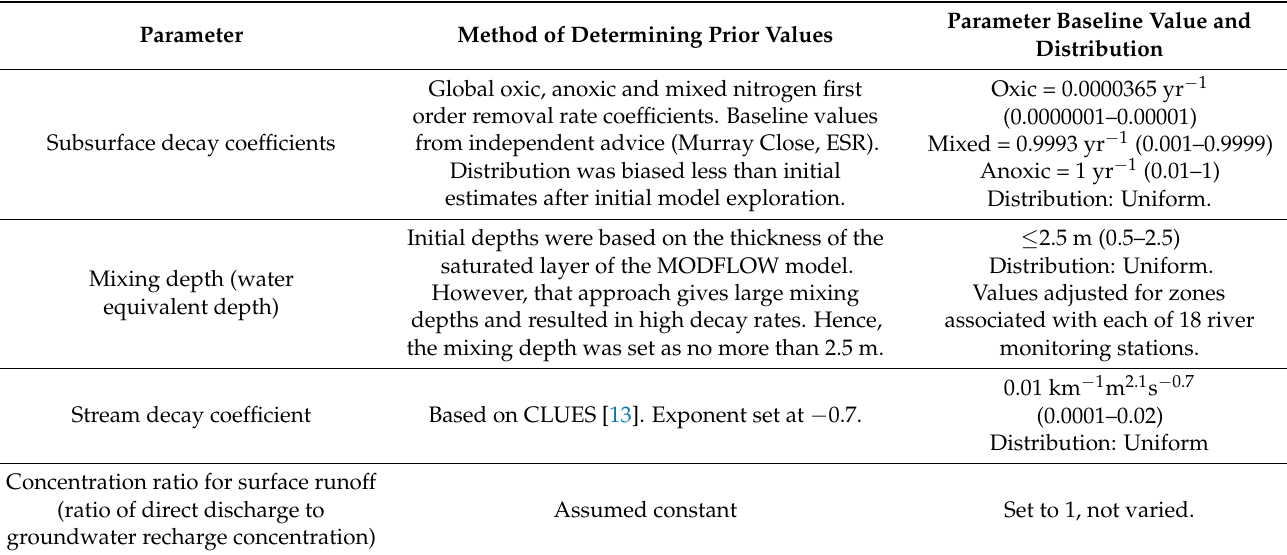
Table 2. Key parameters other than exchange coefficients, methods of determining their prior distribution and the prior distribution, for the Hauraki case